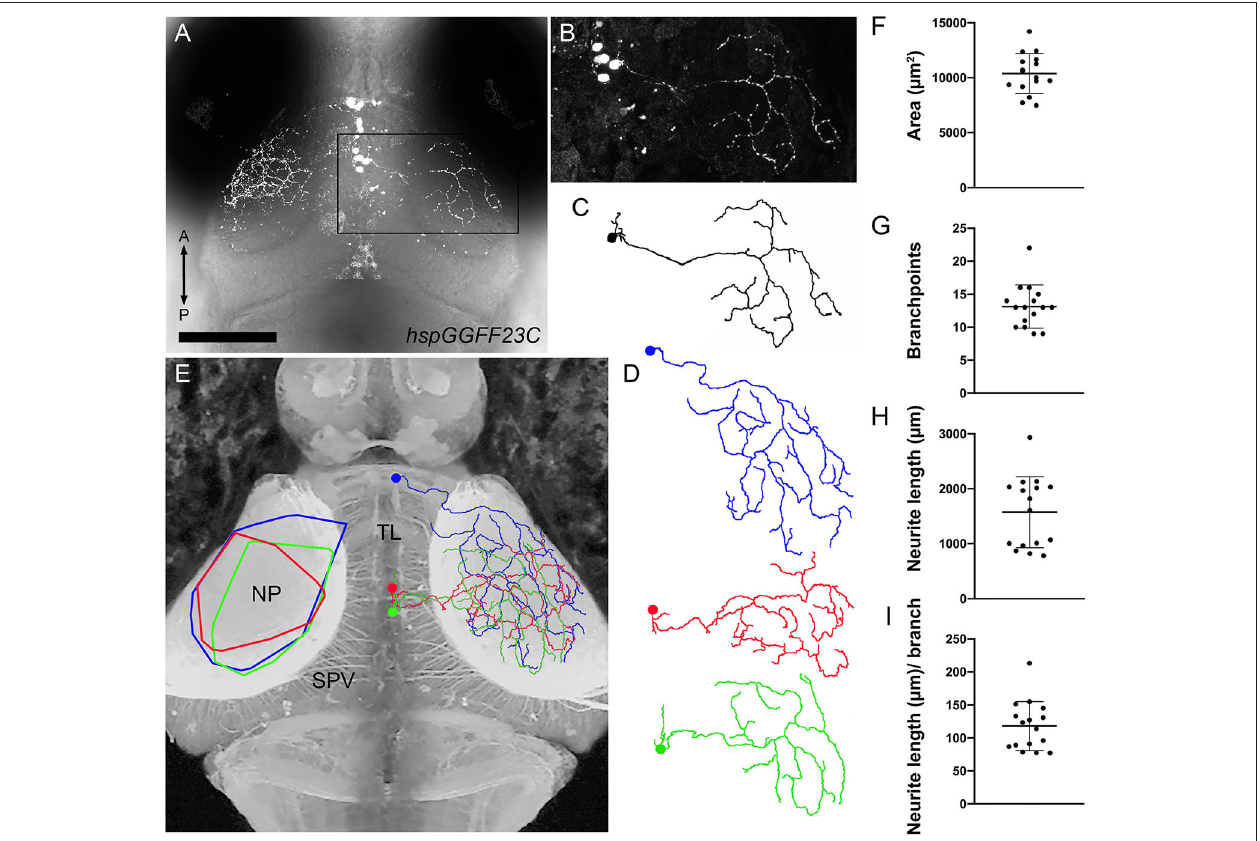
FIGURE 5 | Morphology of individual TL axons innervating SM. (A) Dorsal view confocal image of the midbrain from a 7 dpf Tg( hspGGFF23C:gal4,uas:NTR-mCherry) larva containing several labeled neurons in the left TL lobe and a single neuron in the right TL lobe, indicated by boxed region. (B) Magnified view of boxed region in (A) . (C) Skeletonized tracing of SMTL neuron in (B) . Note large, sparsely branched arbor. (D) Skeletonized tracings of three SMTL neurons. Note large, sparsely branched arbor and small dendritic arbors within TL. (E) Dorsal view inverted fluorescence image of the brain of a Tg( HuC:lynTagRFP-t) larva. Overlayed on the right tectum are reconstructed and appropriately scaled tracings of three SMTL neurons in (D) that innervated SM. Note that the three SMTL neurons vary in their cell body position within TL, but all are located in ipsilateral TL. Overlayed on the left tectum are convex polygons that summarize the SM area spanned by each of the three SMTL axons shown at right. (F–I) Quantification of retinotopic area, branchpoint number, total neurite length, and branching density for 16 reconstructed SMTL axons obtained from 12 larvae. Scale bar: 120 µ m in (A) , 80 µ m in (B–D) , and 90 µ m in (E)